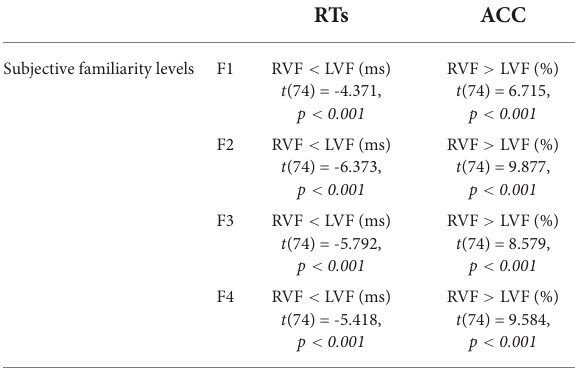
TABLE 6 Results of the BRGs at each subjective familiarity level in response times (RTs) and accuracy (ACC) for words.